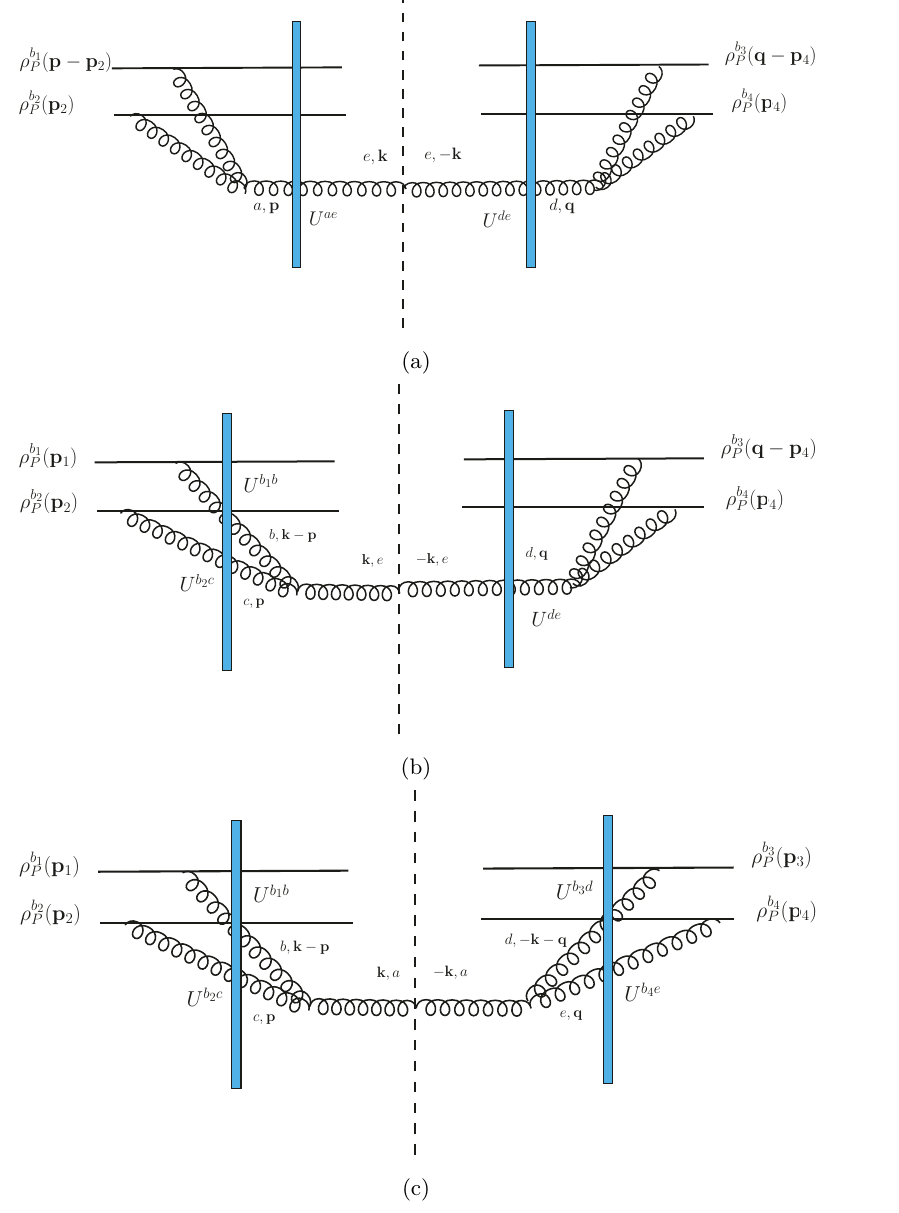
Figure 6 . Color structure for terms in the | M | 2 that contain two, three and four Wilson lines. (3) The dashed line separates the amplitude and the complex conjugate amplitude. In (a) two gluon lines crossing the target nucleus, (b) three gluon lines crossing the target nucleus and (c) four gluon lines crossing the target